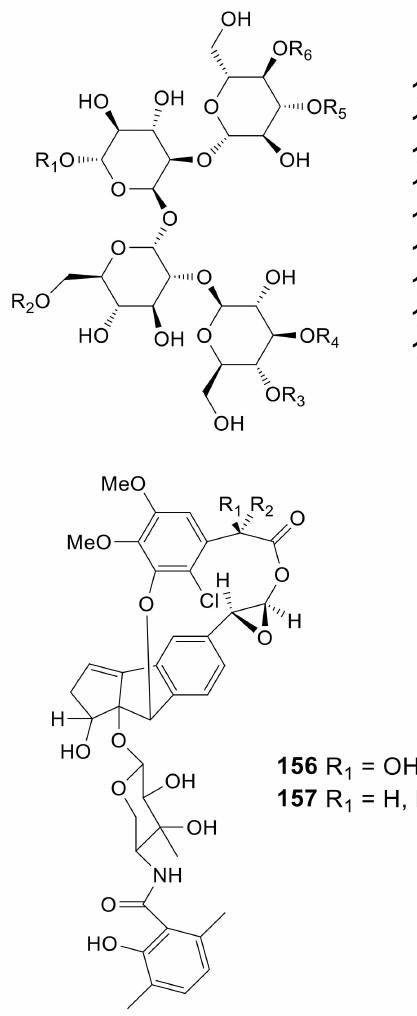
Figure 7. Structures of glycoside derivatives ( 147 – 155 ), enediyne derivatives ( 156 – 157 ) and sesquiterpenes ( 158 – 159 ) from Amycolatopsis